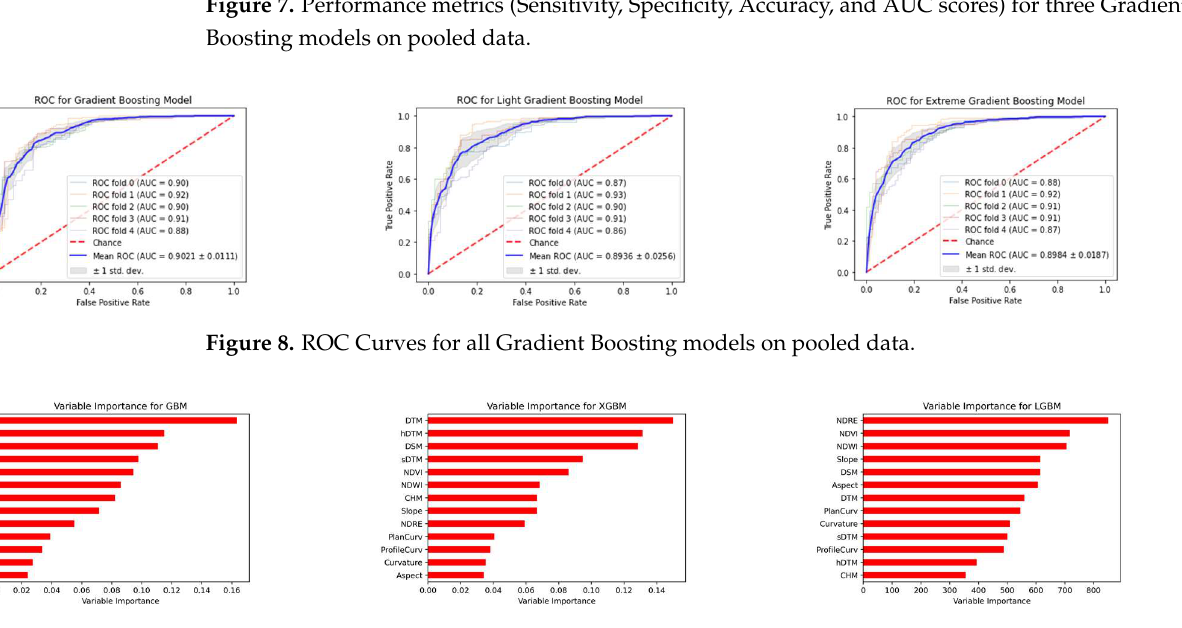
Figure 10. Performance metrics (Accuracy, Sensitivity, Specificity, and AUC scores) for XGBM. There are some similarities in these results to Figure 3. For example, the Maysville site had a much lower sensitivity than specificity in Figure 3, and the same trend holds in